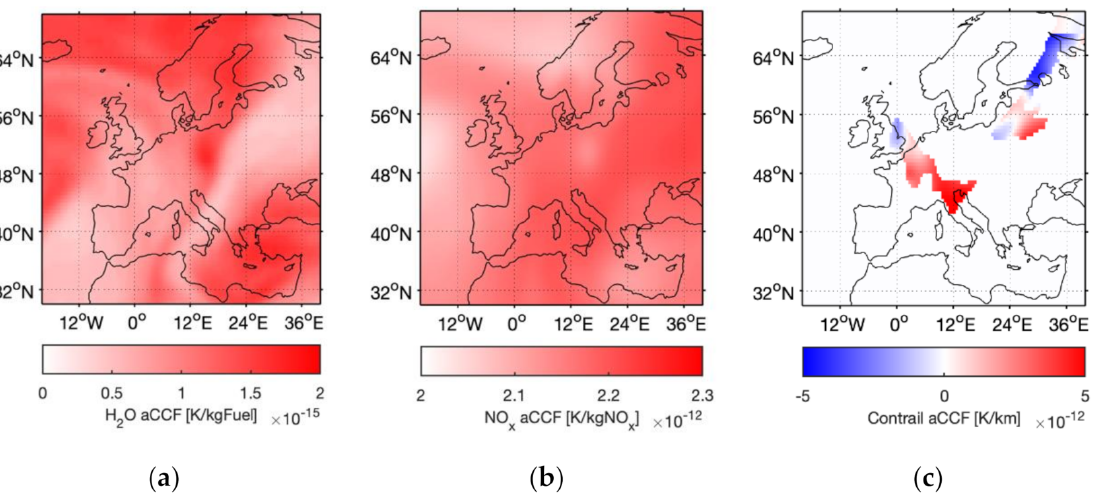
Figure 1. Algorithmic climate change functions for H 2 O ( a ), NO x ( b ), and contrails ( c ) on 18 December 2015, 6.00 p.m. UTC as function of latitude and longitude on flight level 390.